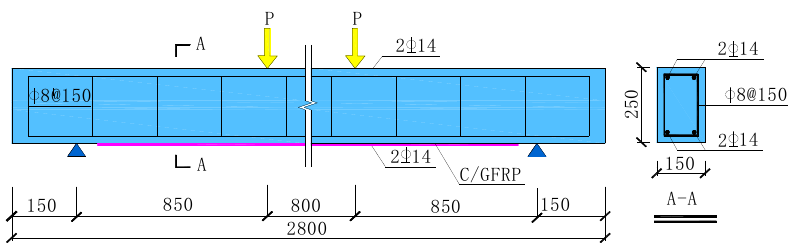
Figure 8. Configuration of the test beam (unit: mm). GFRP, Glass Fiber Reinforced Polymer.